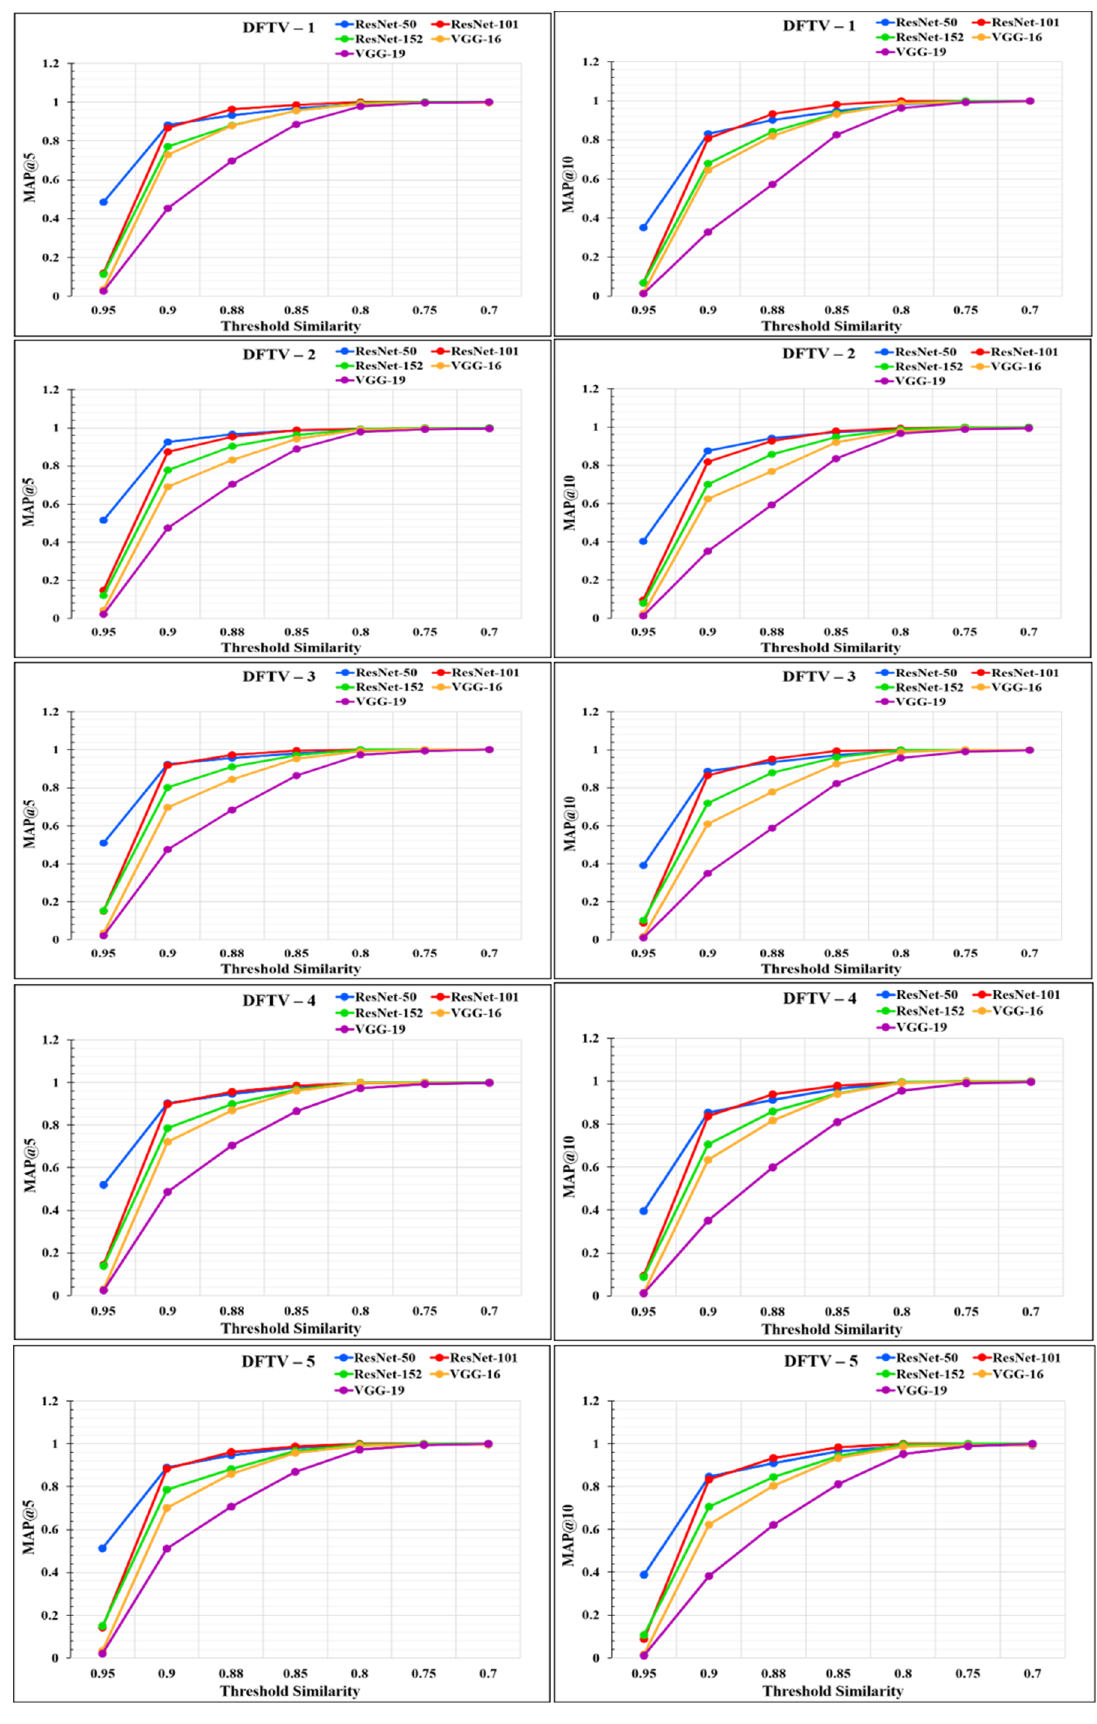
Figure 14. Mean average precision @k graphs for DFTV datasets for k = 5 and k = 10.